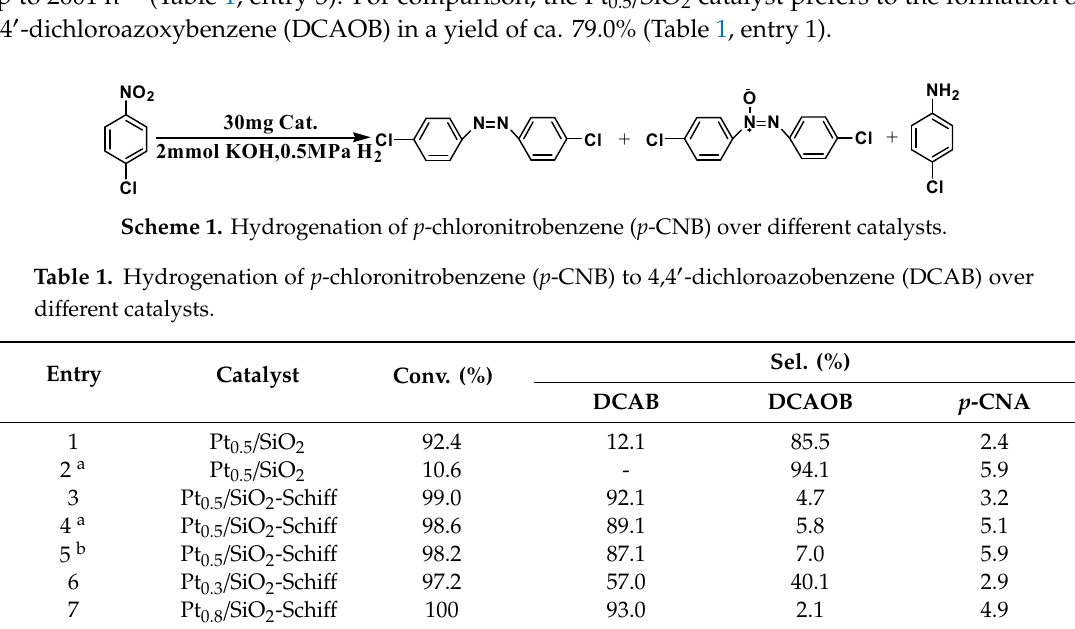
Figure 4. Core level XPS spectra in Pt4f regions of Pt 0.5 /SiO 2 ( a ) and Pt 0.5 /SiO 2 -Schiff ( b ) catalysts.